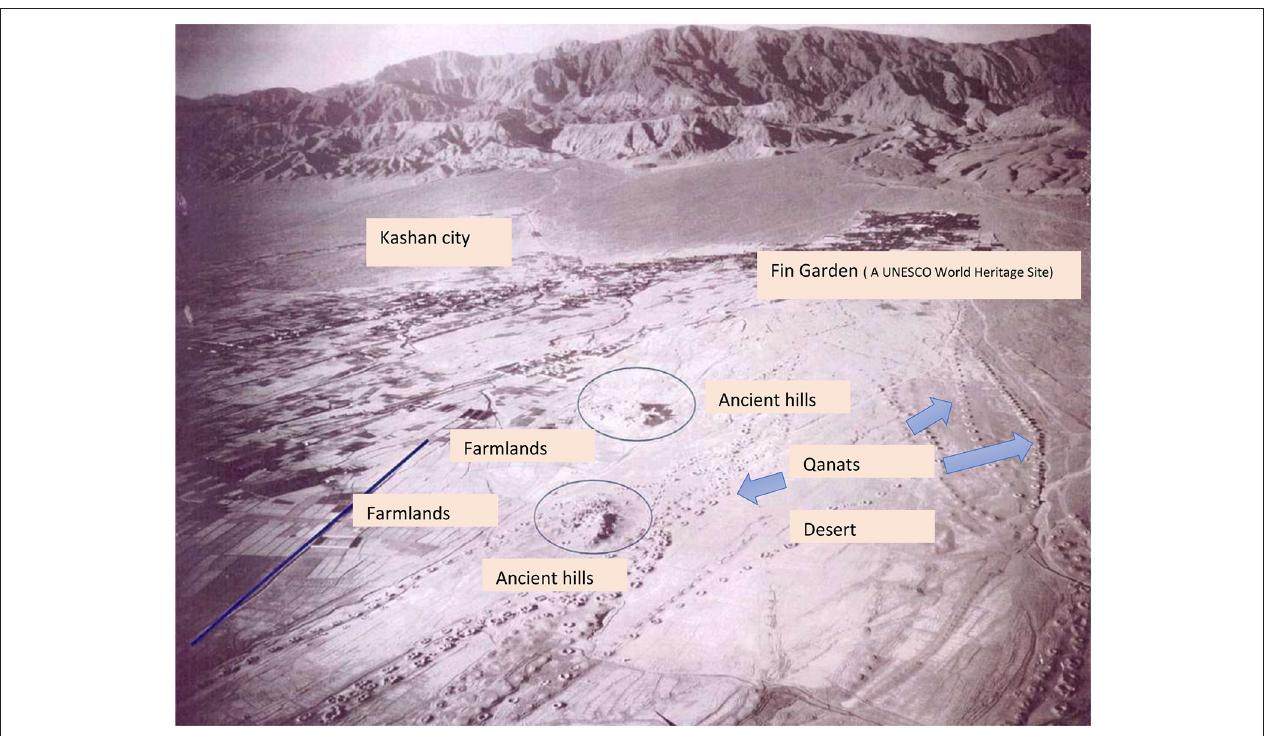
FIGURE 2 | Aerial photograph of Kashan region around 1937 (25,